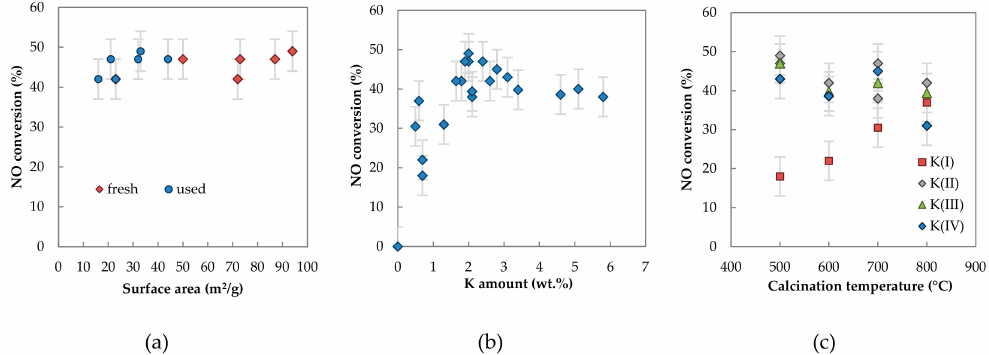
Figure 12. Dependence of NO conversion at 650 ◦ C on ( a ) the surface area of fresh and used K promoted Co–Mn–Al mixed oxides containing similar amount of K (2 wt.%), ( b ) K amount and ( c )